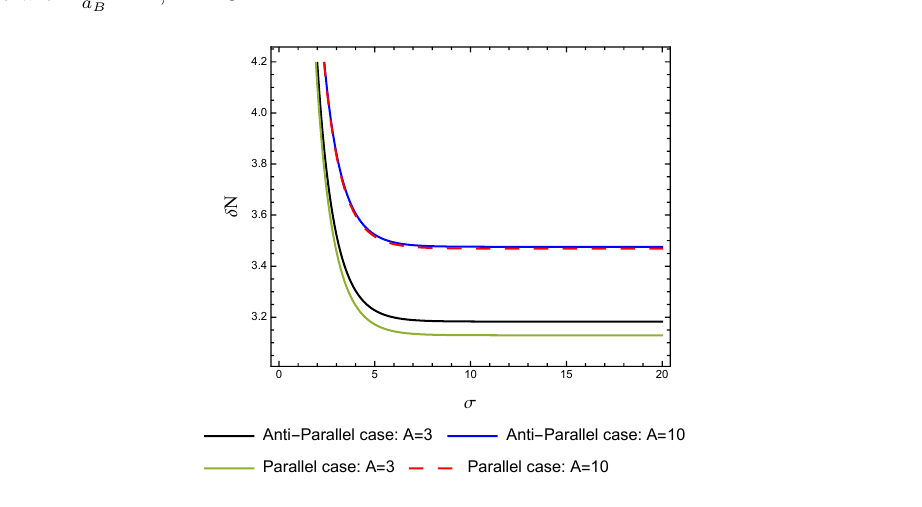
Figure 29 . Parallel and Anti-parallel motions in (1 + 3) dimensions with thermal background: δ N Vs σ plot with ∆ E = 1 , A = 10 a B